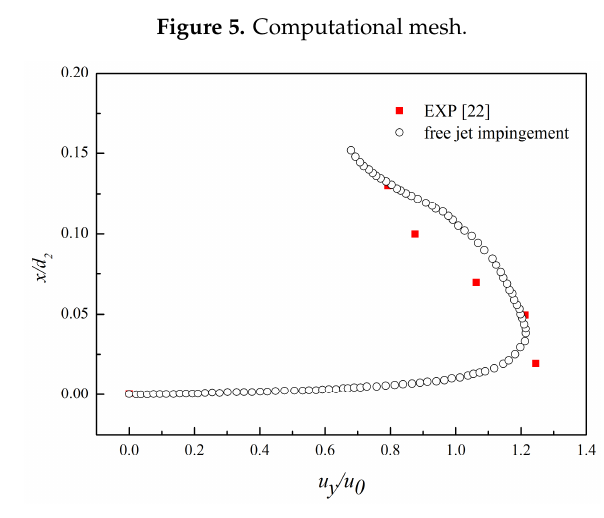
Figure 6. Validation.